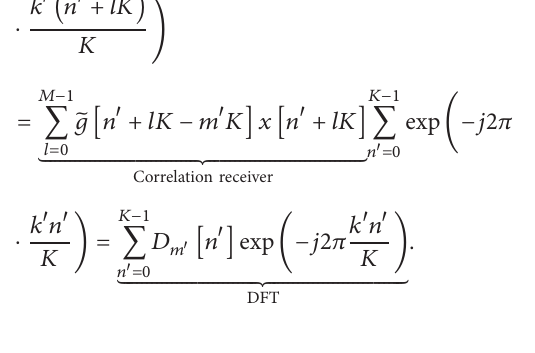
Figure 13: BER comparison between OFDM and GFDM (MCS 16, 20, and 24, 𝛼 = 0.1 , LOS).